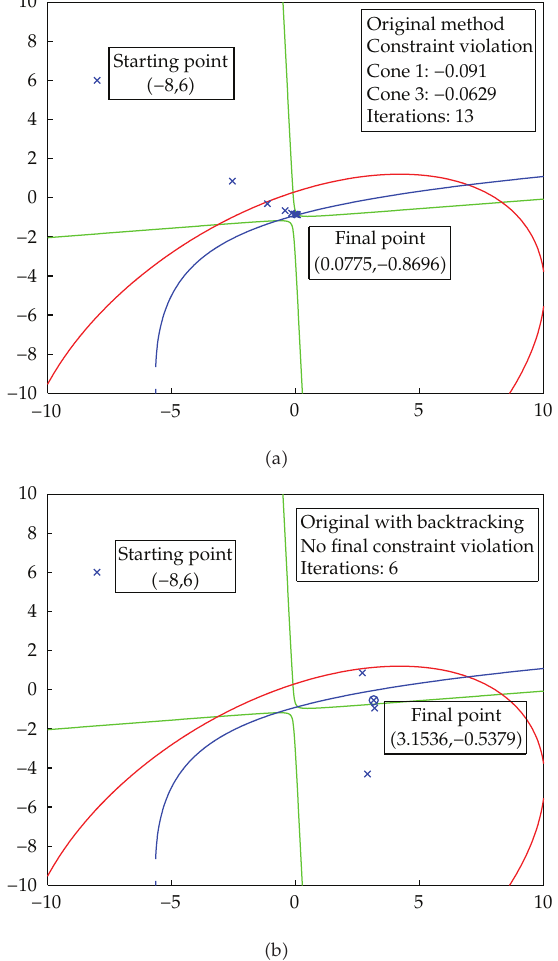
Figure 8: Comparison of Original method and Original method with backtracking applied to Example